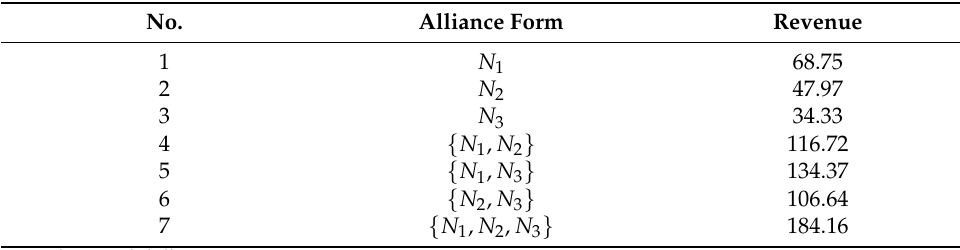
Table 5. Total revenue for each alliance